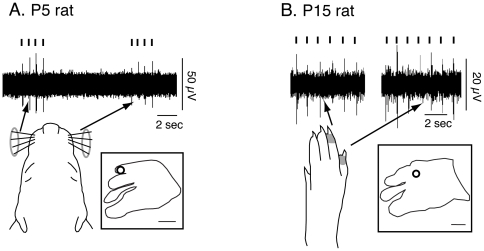
Representative traces of multi-unit activity in a P5 (A) and P15 (B) rat.A) Multi-unit activity in response to stimulation of both ipsilateral (left) and contralateral (right) vibrissae. Tic marks indicate the temporal pattern of stimulation. The inset box includes a depiction of S1 with the recording site indicated by an open circle (scale = 1 mm). B) Multi-unit activity in response to stimulation of toe 4 (left) and toe 5 (right) of the contralateral hindpaw. The receptive field for the neurons is indicated in gray on the schematic of the contralateral hindpaw. The inset box includes an illustration of S1 with the recording site marked by an open circle (scale = 1 mm).